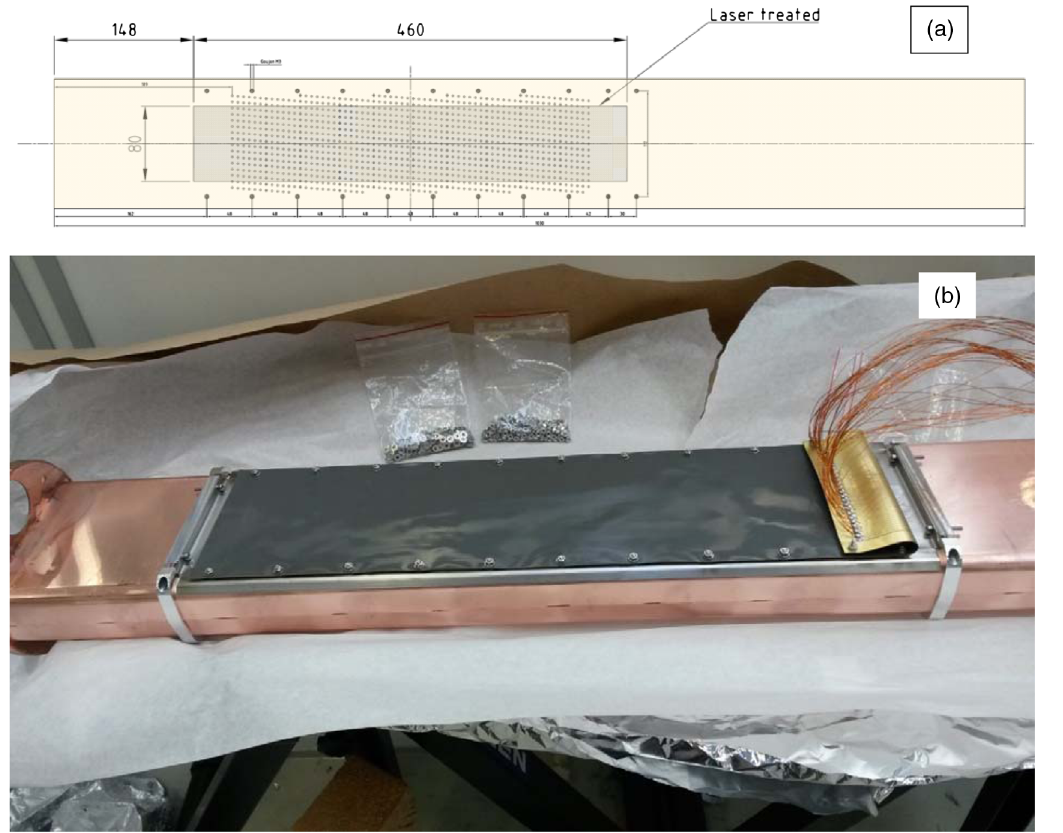
FIG. 2. (a) Schematics of the laser treated region on the top half of the liner; the bottom half is treated symmetrically. (b) One of the finished liners assembled with the stripline monitor before installation in the SPS